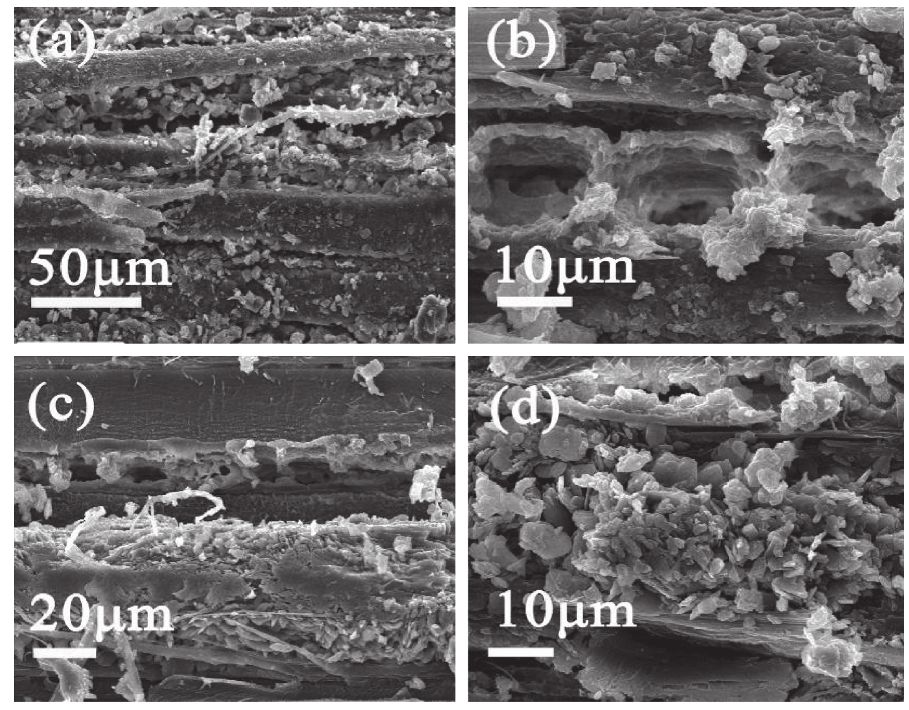
Figure 6: (a–d) SEM images of sample 9F6, where massive salt crystals fill the cell walls.